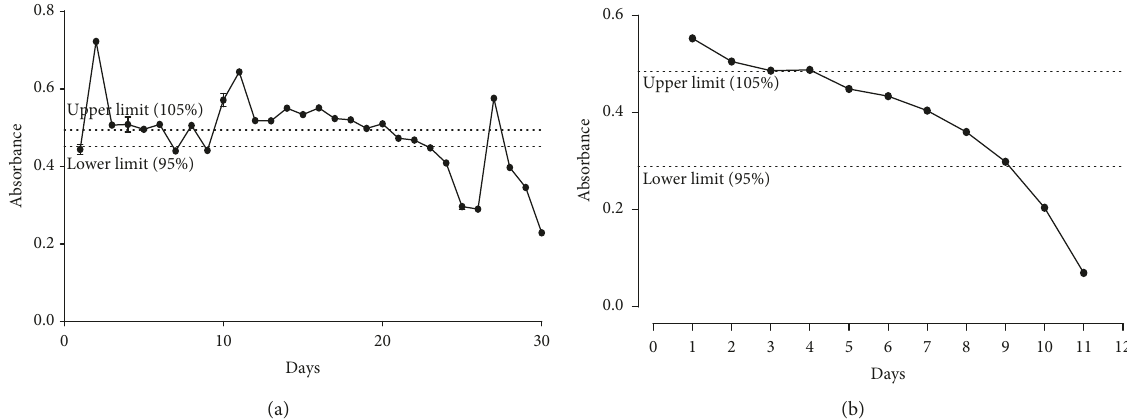
Figure 4: Results showing the stability of the solutions used in the method. (a) The stability of stock solution prepared and kept under refrigeration. The results show that the solution was stable for about 23days, after which the absorbances recorded were significantly different from the initially recorded values. (b) The stability of the 100% concentration calibration solution prepared during the samples analyses. The result showed that the prepared solution was stable for 9days, beyond which it may not be advisable to use such